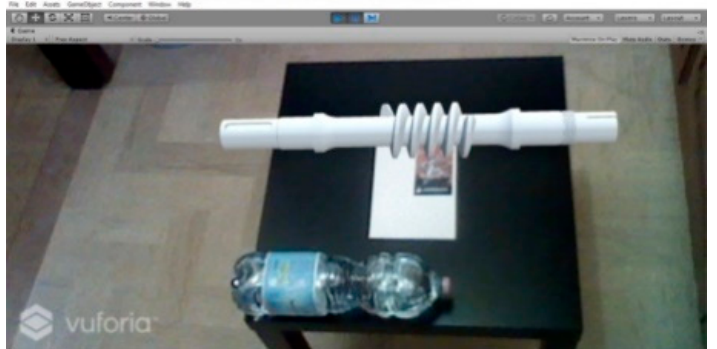
Figure 28. View of the AR tree (scale 1:1).